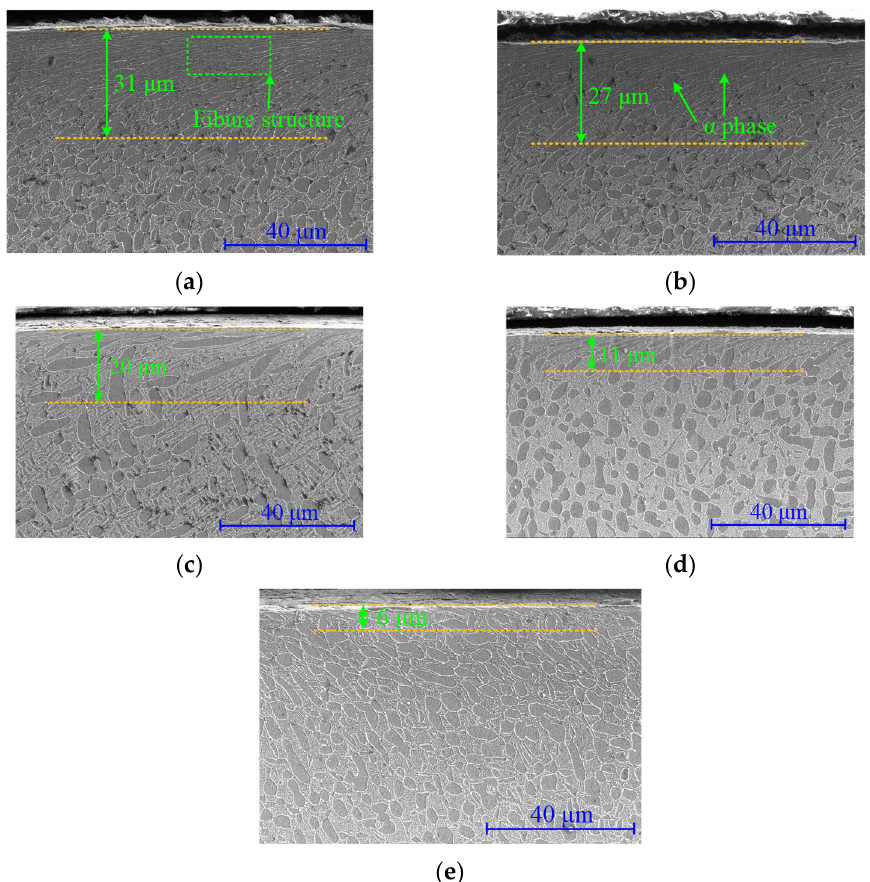
Figure 12. Microstructure characteristics of ultrasonic-impacted surface during fatigue process. ( a ) 0 cycle; ( b ) 1.68 × 10 4 cycles; ( c ) 1.68 × 10 5 cycles; ( d ) 9.66 × 10 5 cycles; ( e ) 1.68 × 10 6